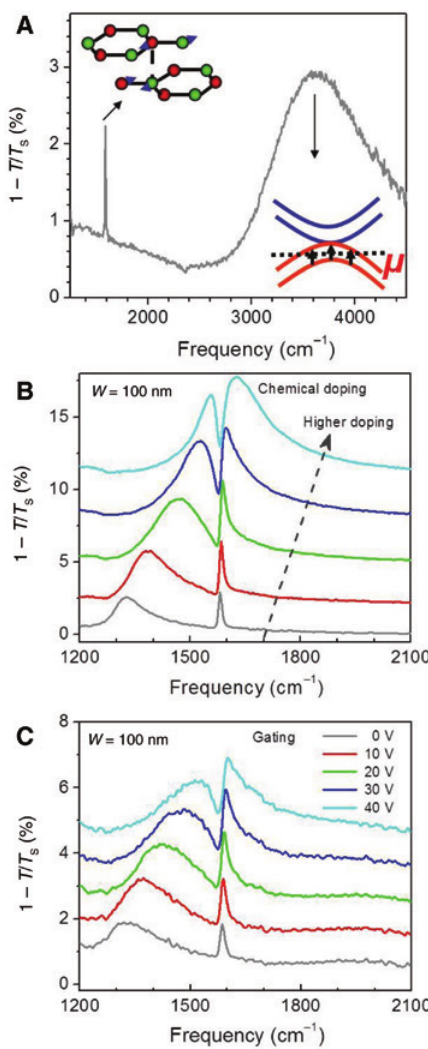
Figure 7: Plasmons in AB-stacking bilayer graphene. (A) Extinction spectrum of unpatterned bilayer graphene. Top